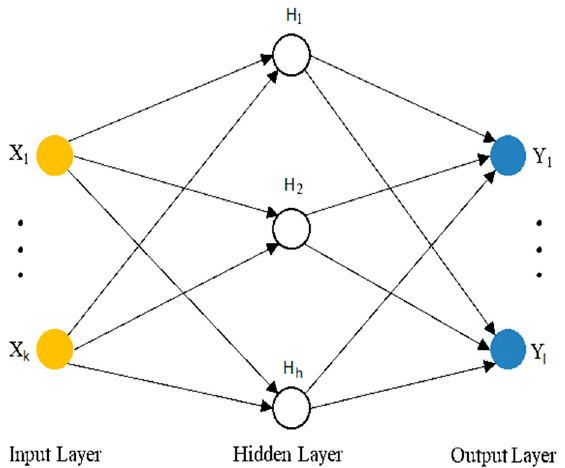
Figure 6. ELM Architecture.